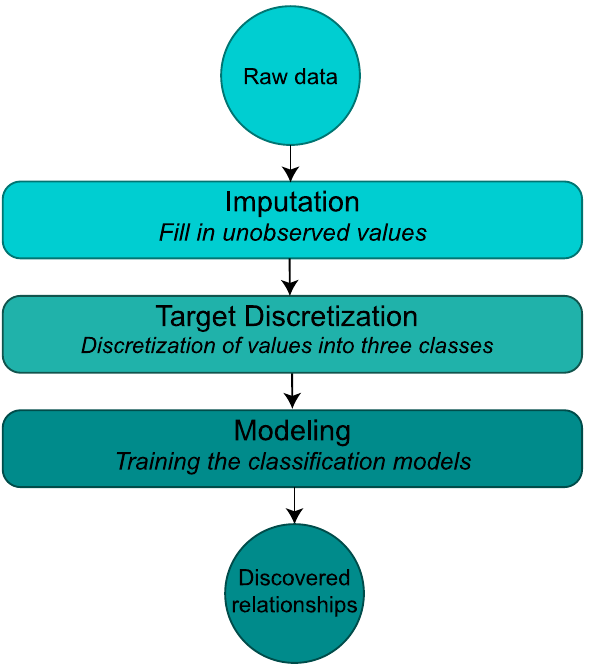
Figure 1. Workflow of the data analysis. Circles show the input and output, rounded rectangles show the base steps, in which the name of step is represented in larger font and the description of the functionality in smaller, italic